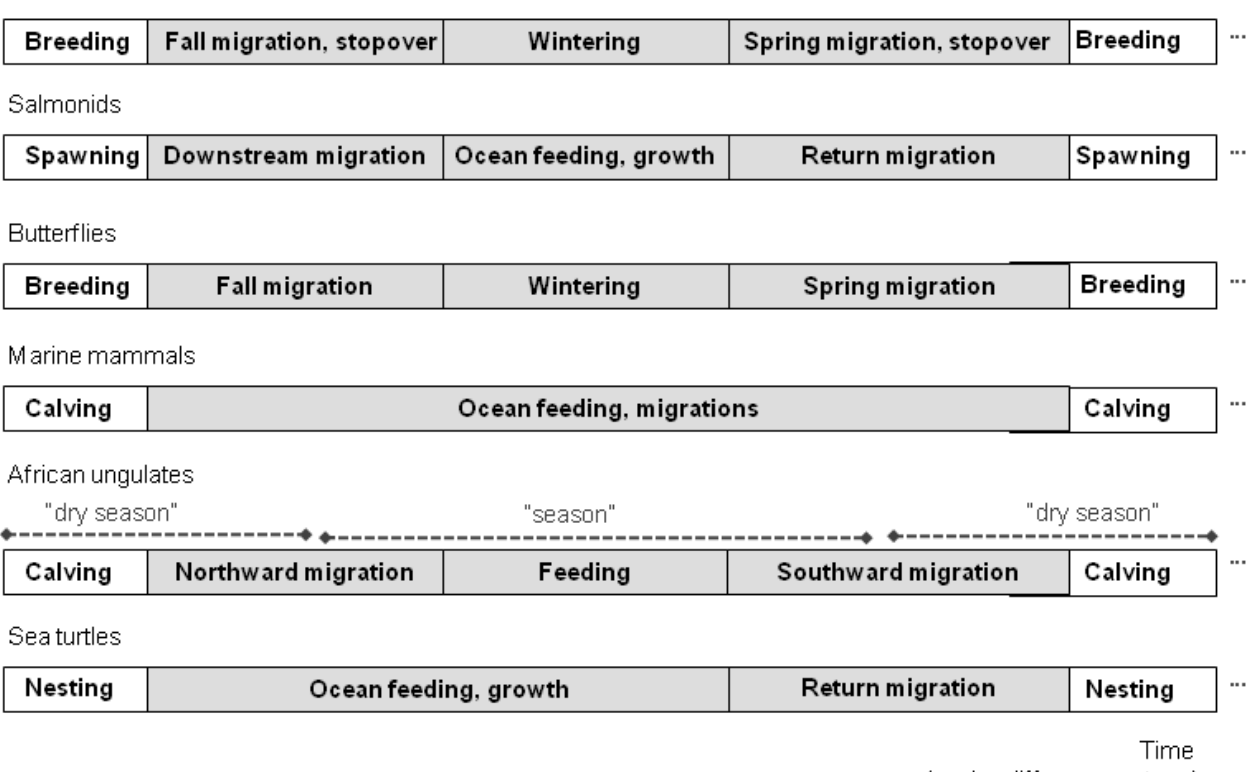
Fig. 1. Schematic illustration of parallel migratory life histories across diverse migratory taxa, and the common names given to each seasonal life cycle phase; nonbreeding seasons are shaded in grey. Note that in cases where mating occurs during “nonbreeding” seasons (e.g., some mammals), the “breeding” season refers to the birthing season. Diagram is not to